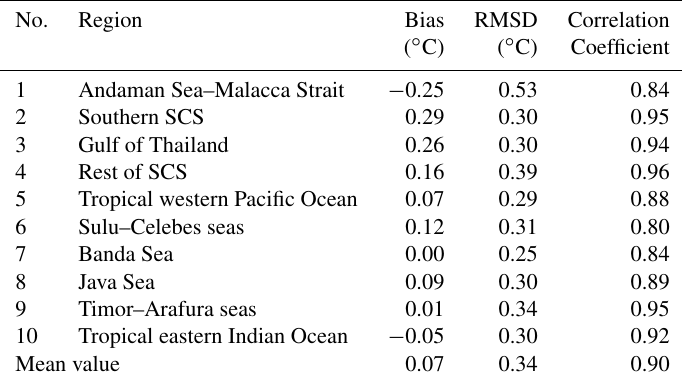
Table 2. Summary of SST bias, RMSD, and correlation coefficient statistics between the model hindcast and OSTIA for the period 1 Jan- uary 2018 to 30 June 2019. Daily mean SST from the model and OSTIA is used for the analysis.